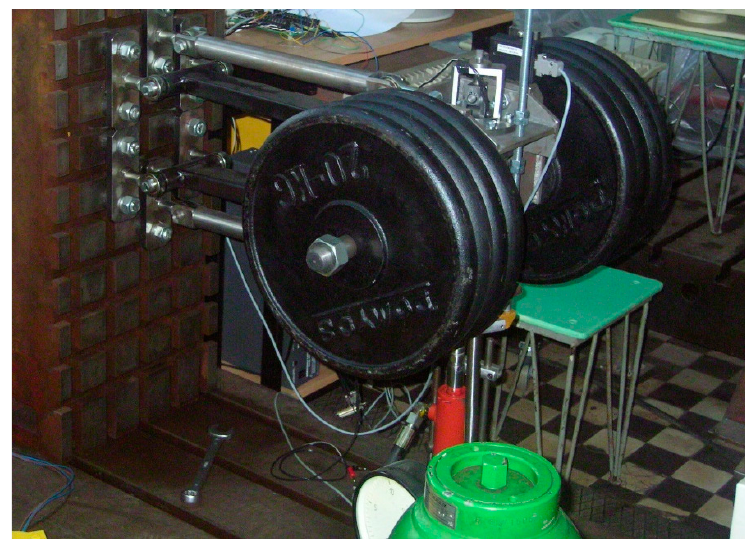
Figure 12. Model of the experimental test bench with controlled suspension.